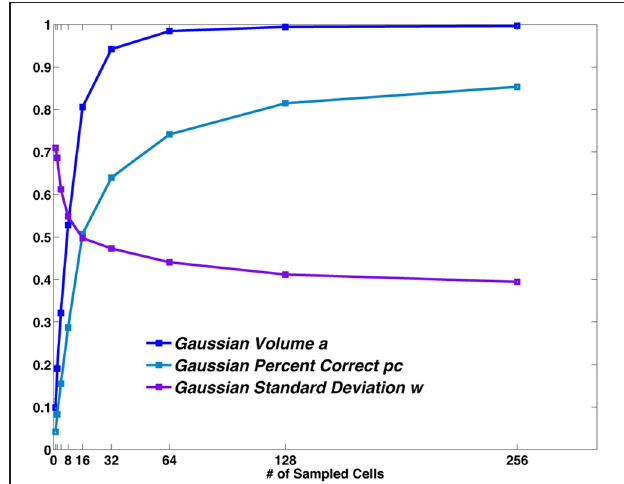
FIGURE 4 | The Gaussian distribution parameters vs. sample size. The values obtained from the fit of the central bump of the reduced matrix, are plotted for different sample sizes. Pc and a are probabilities. w is measured in spatial bin units (each bin is 12.5cm in